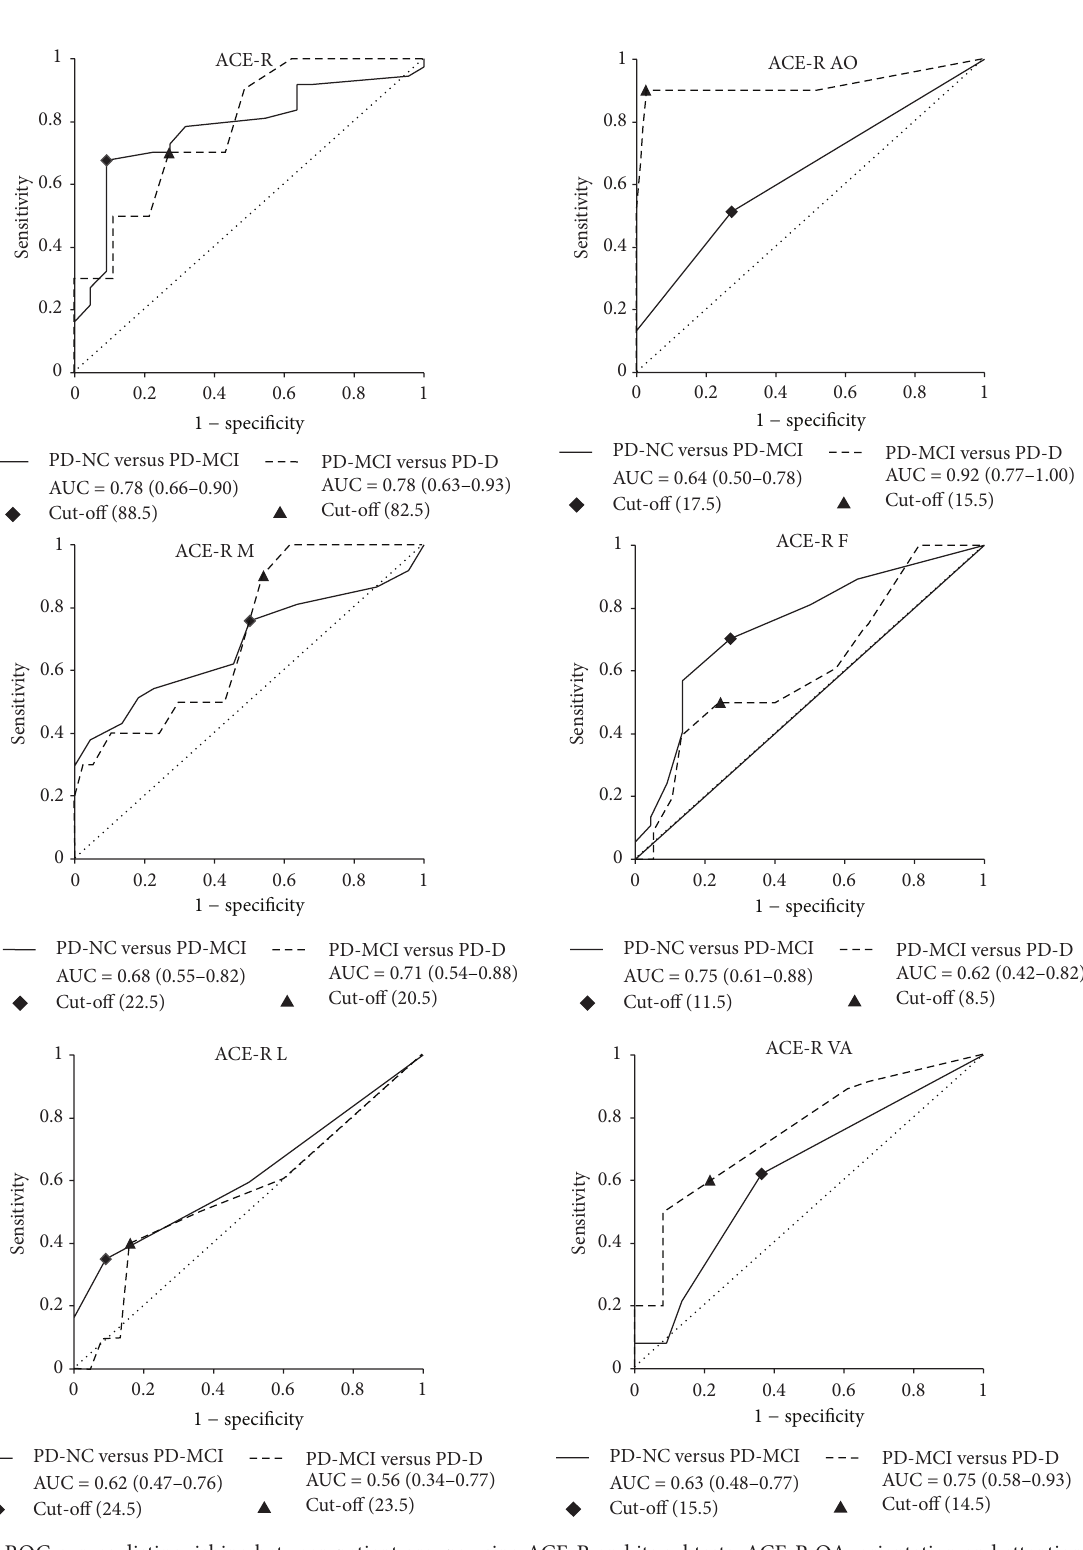
Figure 1: ROC curves distinguishing between patient groups using ACE-R and its subtests. ACE-R OA: orientation and attention domain of ACE-R, ACE-R M: memory domain of ACE-R, ACE-R F: verbal fluency domain of ACE-R, ACE-R L: language domain of ACE-R, ACE- R VA: visuospatial abilities domain of ACE-R, AUC: area under the curve, PD-NC: Parkinson’s disease with normal cognition, PD-MCI: Parkinson’s disease with mild cognitive impairment, and PD-D: Parkinson’s disease with